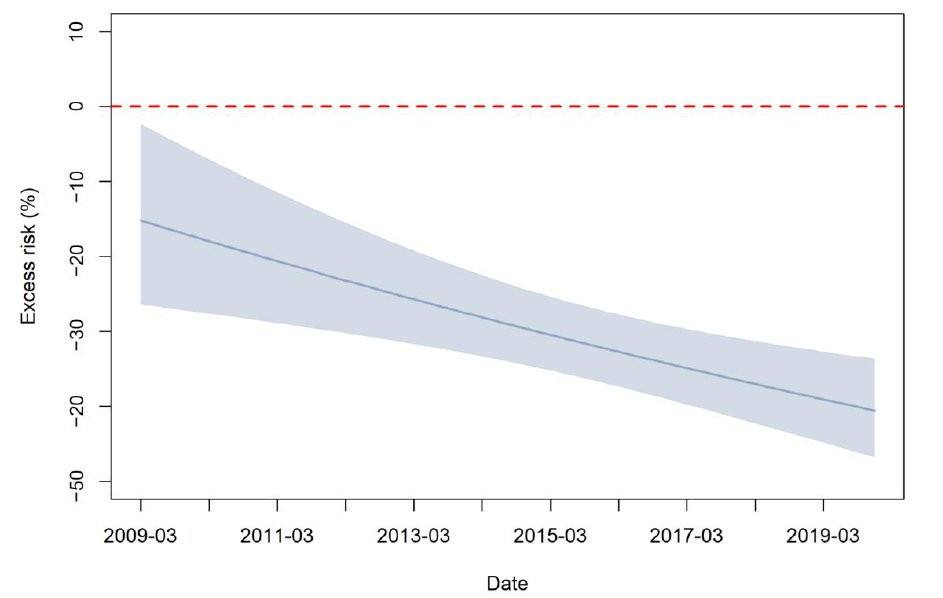
Figure 2. Excess risks of mumps incidence attributable to the EPI-MMR intervention in Guangzhou, China. The shadow represents the 95% confidence intervals of excess risks.